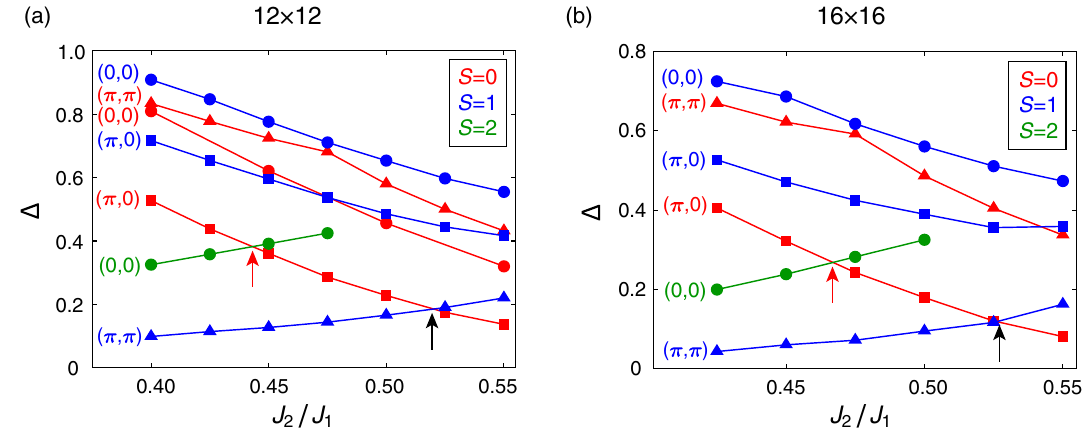
FIG. 3. Low-lying excitation energies for J 1 - J 2 Heisenberg model for (a) 12 × 12 and (b) 16 × 16 lattices. The red and black arrows indicate singlet-quintuplet and singlet-triplet level crossings, respectively.